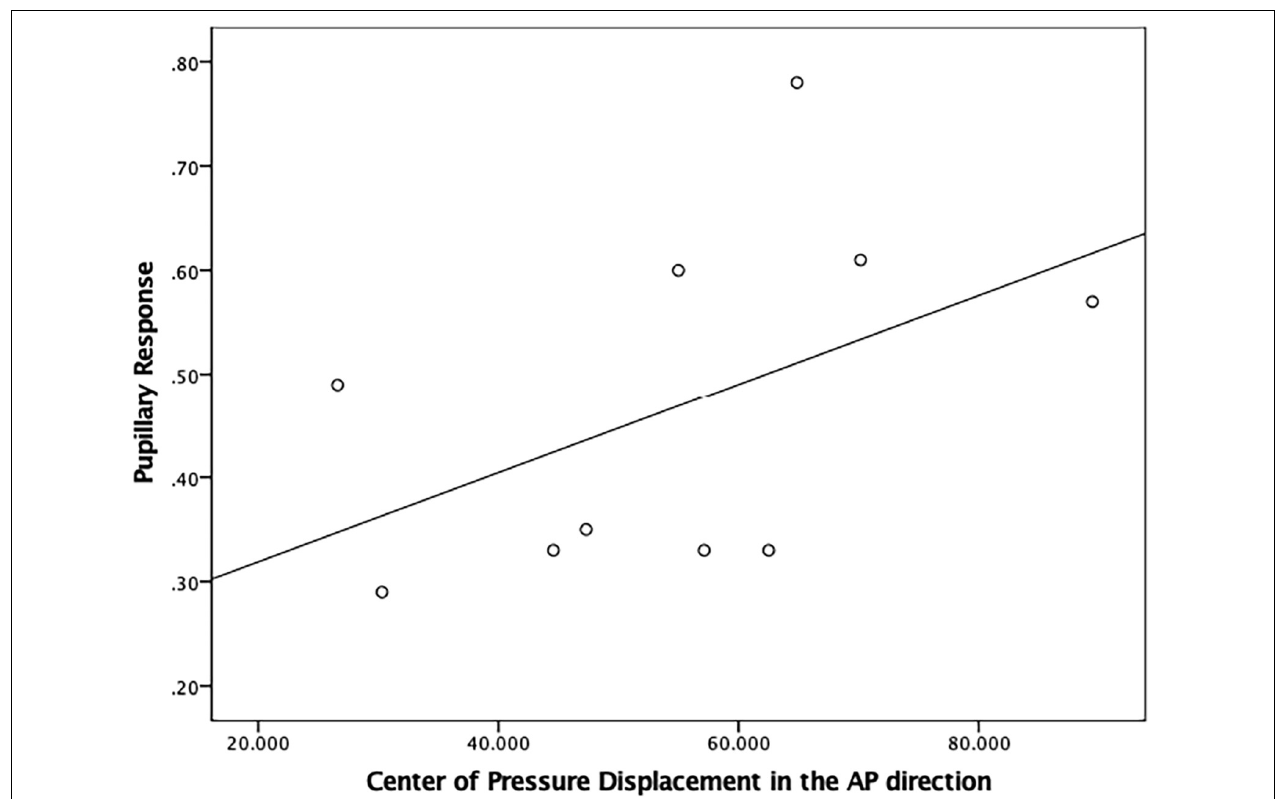
FIGURE 3 | Correlation analysis between pupillary response and Center of Pressure (CoP) displacement (in mm 2 /s) in the Anterior-Posterior direction in PD fallers.